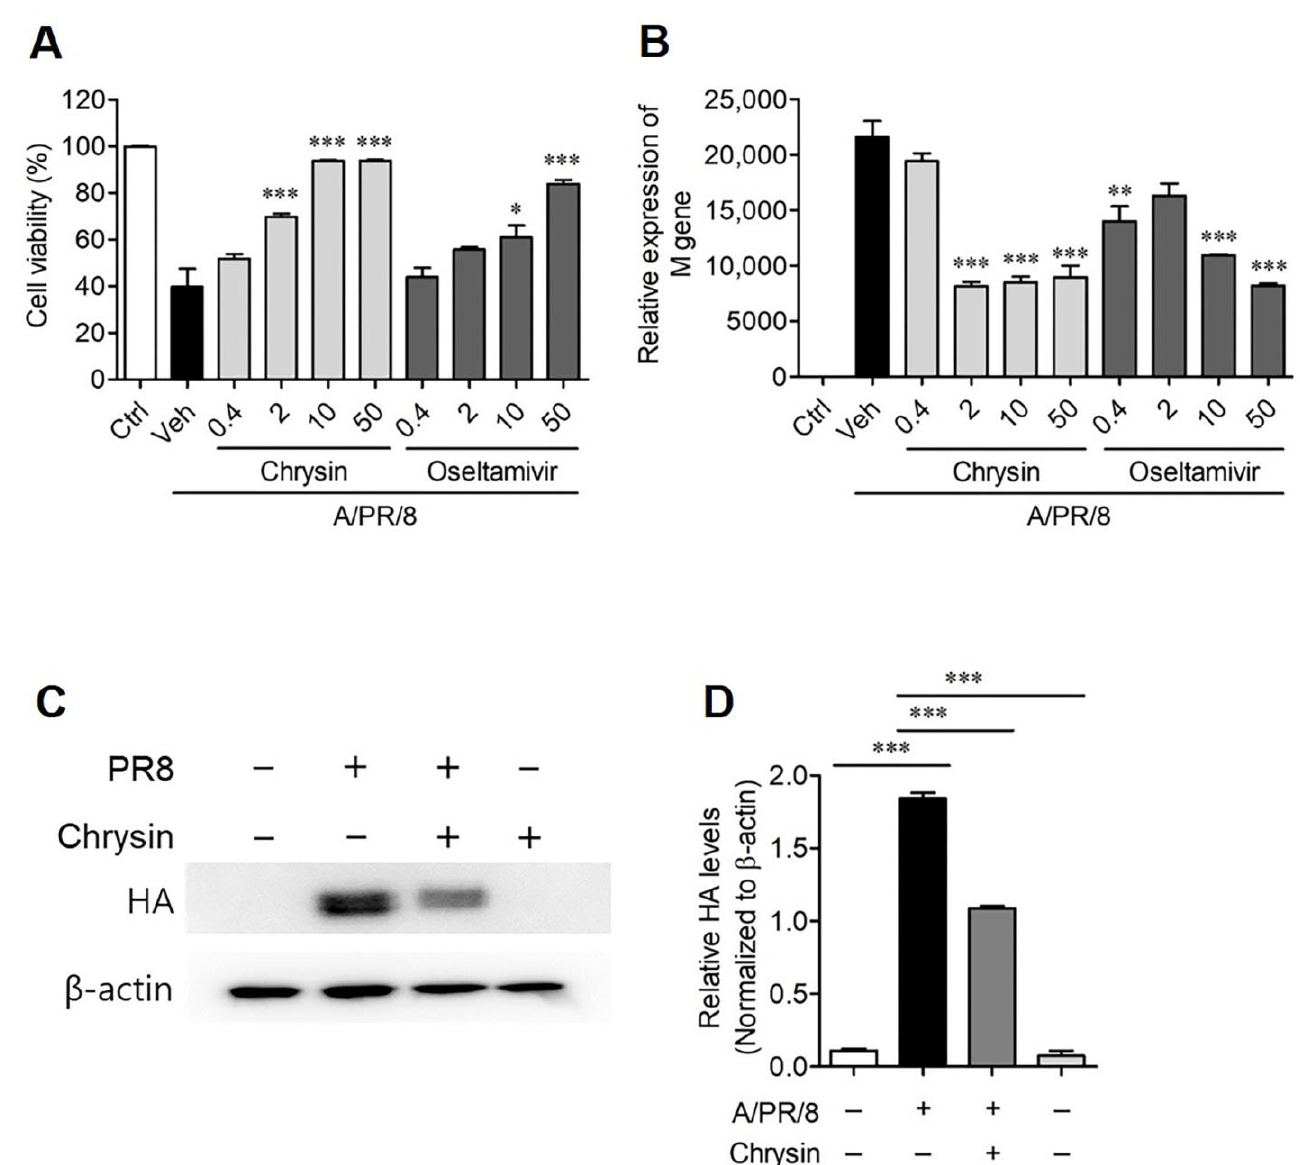
Figure 1. Antiviral activity of chrysin against A/PR/8 in vitro. ( A ) The antiviral activities of chrysin against A/PR/8 were investigated using A549 cells infected with 1 × 10 3 pfu/90 µL of A/PR/8. The viability of cells was measured using an SRB assay, and the antiviral activity was calculated based on the cell viability. The results are shown as mean ± SEM. * p < 0.05, ** p < 0.01, and *** p < 0.001 for comparison with the A/PR/8-infected vehicle-treated group (Veh). ( B ) Relative A/PR/8 gene expression in A/PR/8-infected A549 cells was determined using real-time PCR. * p < 0.05, ** p < 0.01, and *** p < 0.001 for comparison with Veh based on ANOVA with Bonferroni’s multiple comparison test. ( C ) Western blot analysis of HA in A/PR/8-infected and non-infected A549 cells after treatment with the vehicle or 25 µM of chrysin for 24 h. ( D ) The ratio of HA to β -actin based on the quantification of the bands in the immunoblot, as shown in ( C ). Data are expressed as mean ± SD of the values obtained from three independent experiments carried out in triplicates. * p < 0.01, ** p < 0.001, and *** p < 0.0001 based on ANOVA with Bonferroni’s multiple comparison test.